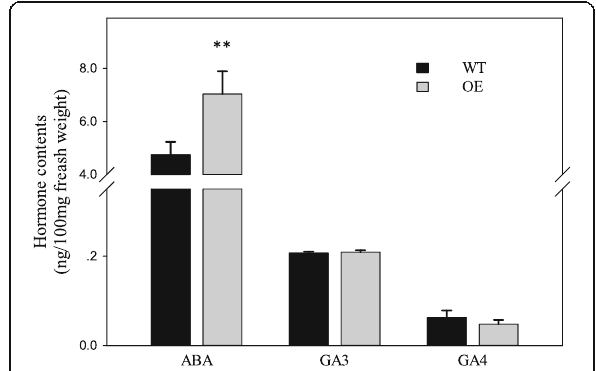
Fig. 2 ABA and GAs contents in seeds of OE and WT lines. At 23 DAH, seeds from three OE lines and WT were harvested and stored in liquid nitrogen until analysis. Values represent the mean ± SD of at least three replicates. Student ’ s t-tests were used to generate P